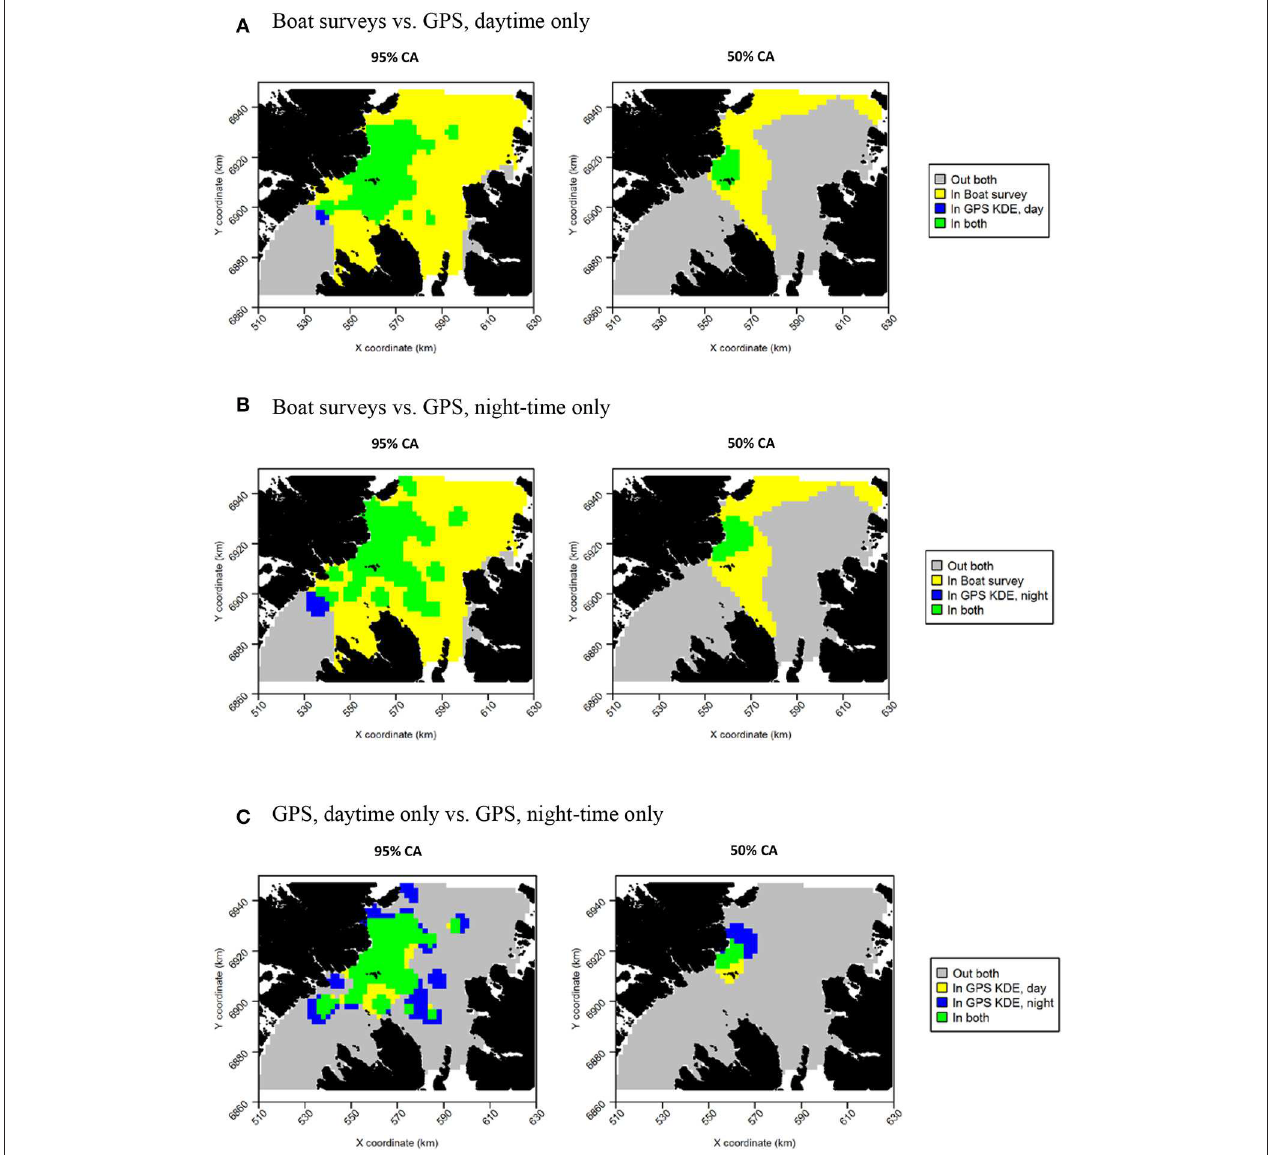
FIGURE 9 | Overlap between guillemot core areas (CAs) derived from boat surveys, GPS tracking in daytime and GPS tracking at night-time. In all maps, gray indicates areas outside of the CA in both data sources, and green indicates areas inside the CA in both data sources; blue and yellow indicate areas in the CA in one data source but not the other. (A) Boat surveys vs. GPS, daytime only. (B) Boat surveys vs. GPS, night-time only. (C) GPS, daytime only vs. GPS, night-time